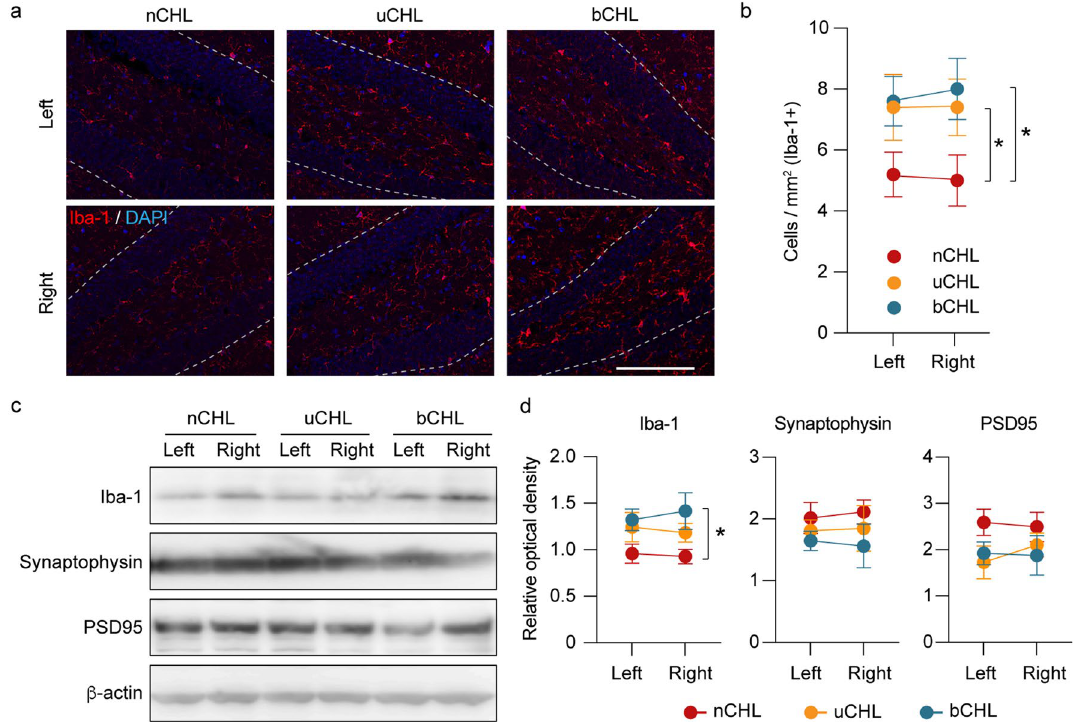
Figure 4. Iba-1 immunohistochemistry of the hippocampus and western blot analysis one week after ear occlusion. ( a ) Representative micrographs of hippocampus in DG stained for Iba-1 one week after ear occlusion. Scale bar indicates 100 μm. ( b ) Significant differences in the number of Iba-1-positive cells in both ears among the groups of mice were observed. No significant differences were detected between the right and left DG across groups. ( c ) Representative western blots for Iba-1, synaptophysin, and PSD95 one week after ear occlusion. ( d ) The expression levels of Iba-1 in uCHL and bCHL mice were upregulated one week after ear